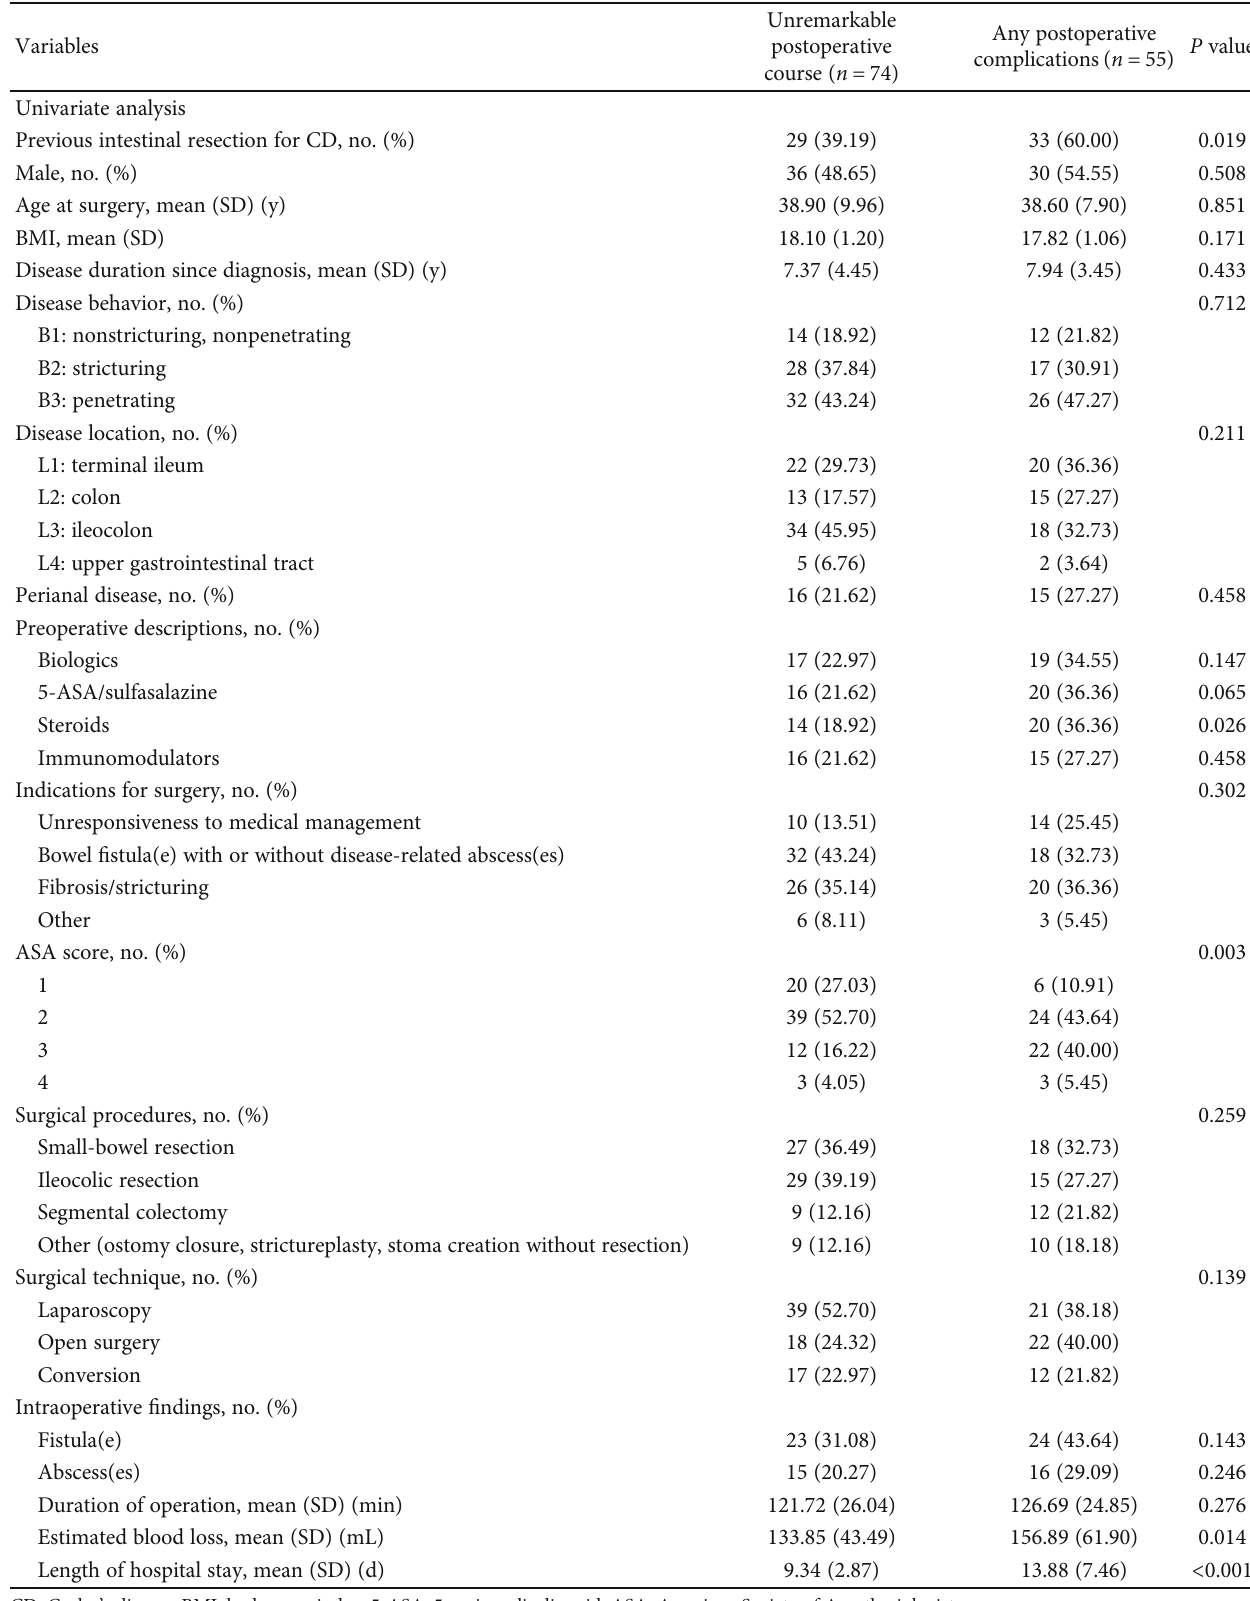
Table 4: Risk factors associated with postoperative